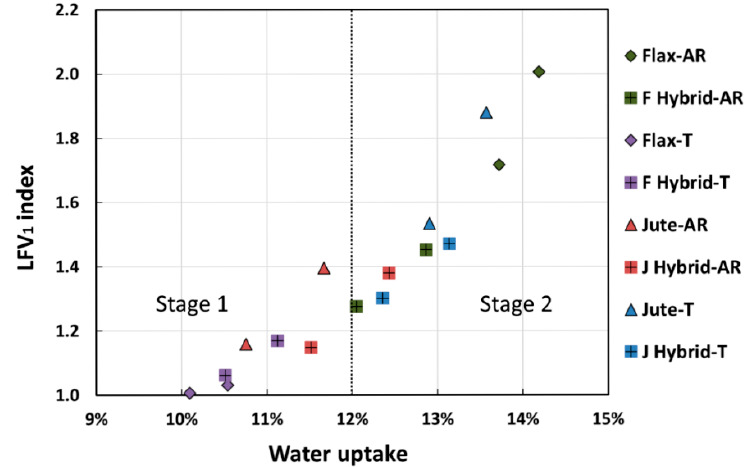
Figure 9. Relationship between moisture content and the variation of first loss factor peak (LFV 1 index).